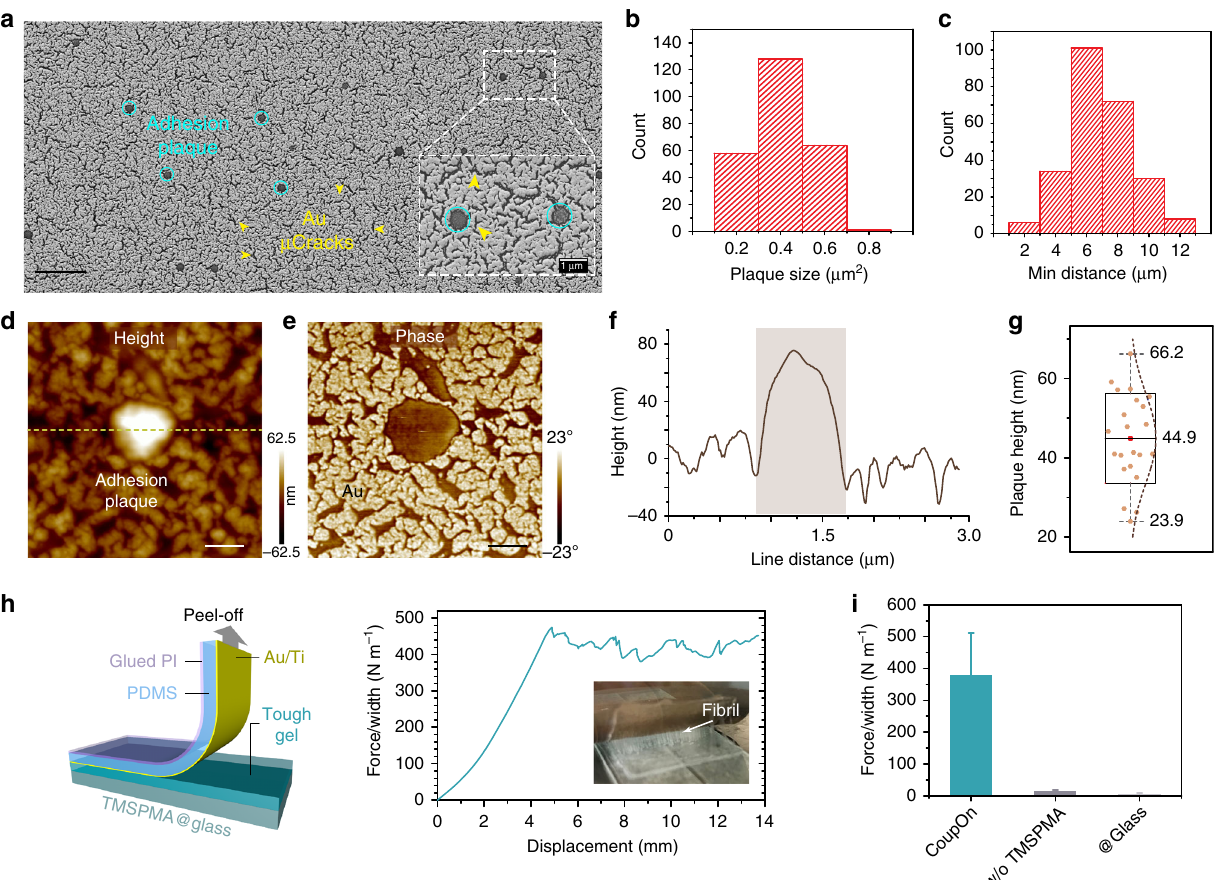
Fig. 2 Formation of cytoadhesion-like plaques endowed the strong interlayer bonding. a SEM image shows the formation of discrete hydrogel-elastomer adhesion plaques (cyan circles), which are out of the metallic nano fi lm through the microcracks (yellow arrowheads) as shown in the inset (dash white rectangle). Representative of three samples after elastomer removal. Scale bar, 5 µ m. b Histogram plot shows the size distribution of adhesion plaques. c Histogram plot shows the distribution of minimum distances between adhesion plaques in proximity. Two hundred and forty-six adhesion plaques are analyzed. d AFM height pro fi le shows the out-of-plane adhesion plaques (white zone). e AFM phase image showed a clear distribution of metallic nano fi lm and microcracks fi lled by the tough gel. Representative image of three samples. Scale bar, 0.5 µ m. f Line plot shows the height pro fi le along the dash line in d . g Box chart shows the height of adhesion plaques compared to the peripheral metallic nano fi lm. Twenty-two adhesion plaques are analyzed. Upper and lower whisker denote the max and min data value, upper and lower quartile denote ± SD, middle quartile denotes the mean. h Schematic illustrates the 90° peel-off test setup and line plot shows the interlayer adhesion between the metallic nano fi lm/elastomer and tough gel. Inset: Photograph shows the formation of fi brils during the peel-off test. i Bar chart shows the adhesion strength of different interfaces. “ w/o TMPSPMA ” group refers to non-silanized metallic nano fi lms on PDMS, “ @Glass ” group refers to Au/Ti nano fi lms on the glass that forms non-microcracked Au/Ti nano fi lms. Representative of three to fi ve samples with a dimension of 1.5 cm by 4.0 cm. Data are presented as mean ±